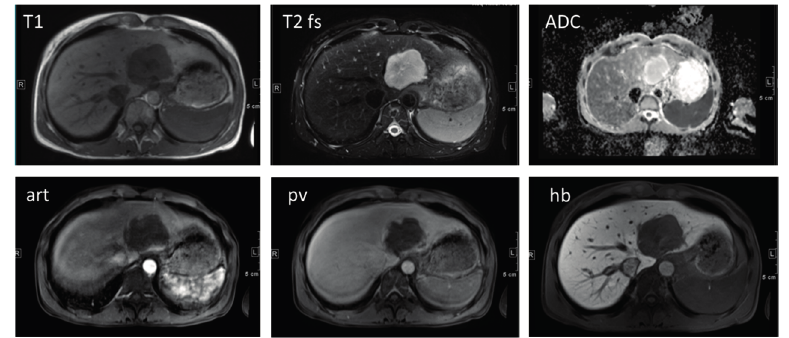
Figure 3. A 47-year old female patient with a large haemangioma in the left liver lobe.